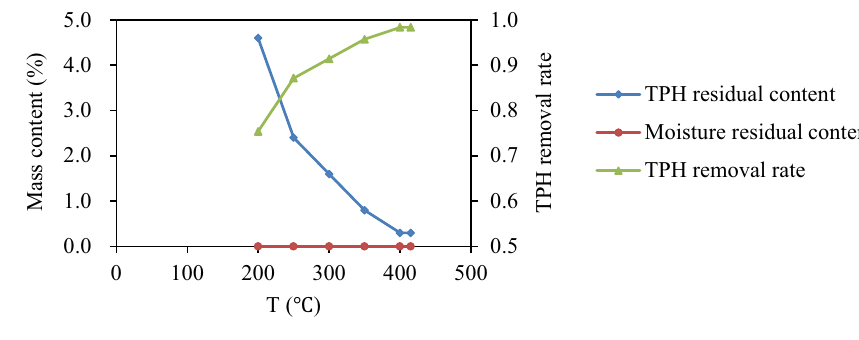
Fig. 4 Residual content of TPH and moisture in solid slag at different terminal temperatures (the residence time of 30 min)